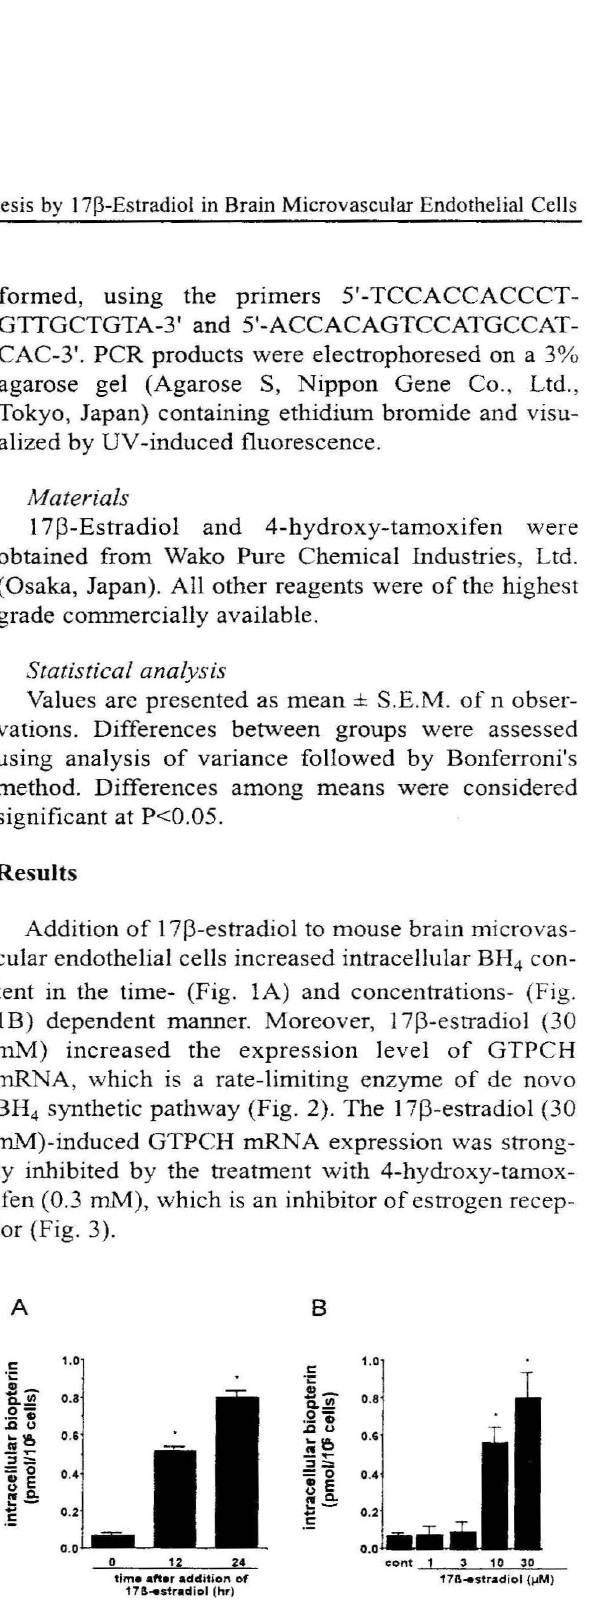
Figure 1. Effect of 17I3-estradiol on BH4 content in mouse brain microvascular endothelial cells. A: endo thelial cells were incubated with 17I3-estradiol(30 flM) for various periods, and then changes in BH4 content were measured. B: endothelial cells were incubated with various concentrations of 17I3-estradiol for 24 hr, after which the BH4 content was measured. Results are represented as the mean ± SEM. *Significantly differ ent from 0 hr group